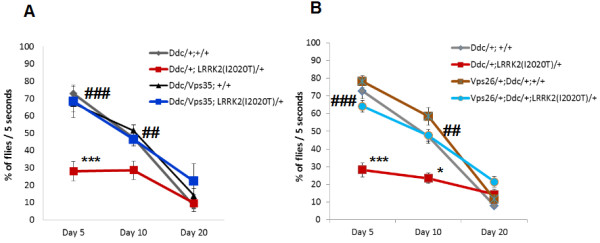
Overexpression of Vps26 or Vps35 in DA neurons rescues LRRK2(I2020T) locomotor deficits. (A) Overexpression of Vps26 in DA neurons. (B) Overexpression of Vps35 in DA neurons. N = 3-12 cohorts of ten per genotype. All flies were reared at 29°C. Statistical analysis: Two-Way ANOVA, Tukey’s post-test. Statistically significant difference compared to control (Ddc alone) is denoted as * for P < 0.05 and *** for P < 0.0001. Statistically significant difference compared to Ddc/+;LRRK2(I2020T) is denoted as ## for P < 0.001 and ### for P < 0.0001.